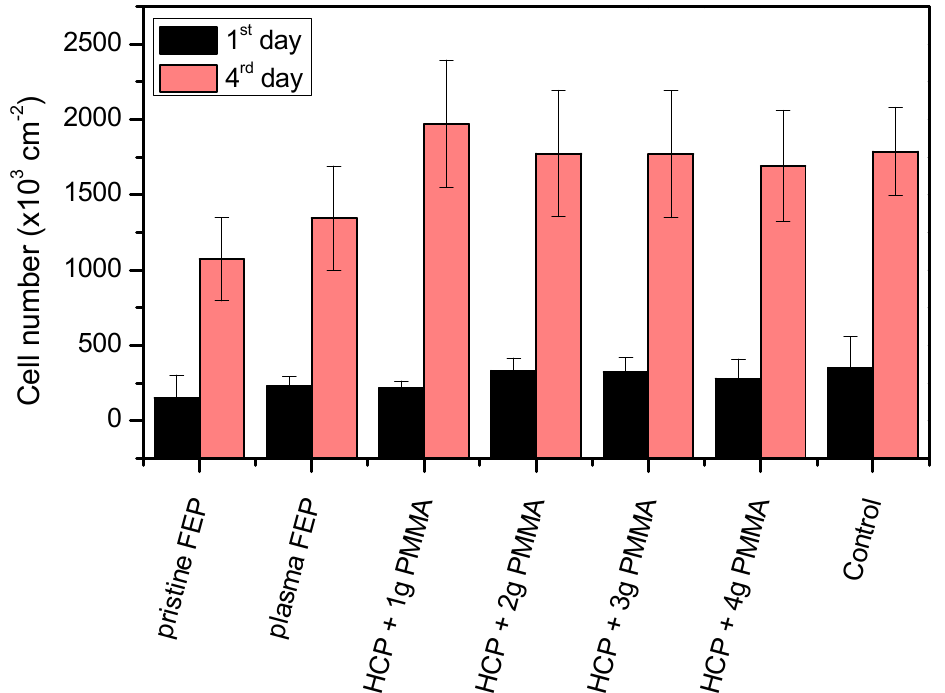
Figure 5. The number of adhered (24 h) and proliferated (96 h) VAMPIRO U-2 OS cells on a pristine and plasma-treated (plasma) fluorinated ethylene propylene (FEP) film and plasma-treated FEP films subsequently coated with honeycomb-like patterns formed from different polymethyl methacrylate (PMMA) solutions (1–4 g) and tissue culture polystyrene (TCPS, control). Another evaluation of the cellular response, morphology, was studied on samples with cultured U-2 OS cells for 1 and 4 days, shown in Figure 6. Images of the cell samples were captured by fluorescence microscopy. After the first day, round cells were detected with irregular spreading on pristine FEP samples and with a layer of 3 g and 4 g of PMMA, which did not correspond to the shape of osteoblasts. In comparison, the control sample showed a cell morphology similar to the shape of osteoblasts. Samples with plasma modification and 1 g and 2 g PMMA had a cell shape similar to the control, but their distribution was not regular. After day 4, all prepared samples were completely covered with cells, except for the pristine FEP sample. This phenomenon could be due to the smooth surface of the unmodified FEP. The shape of the cells after day 4 can no longer be recognized in all sample